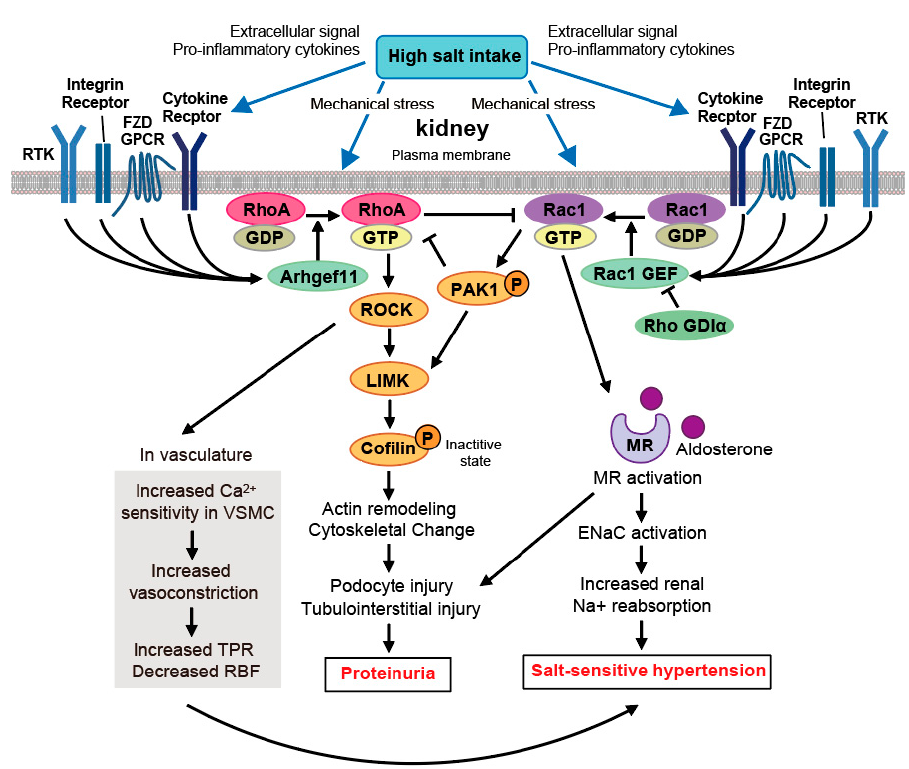
Figure 2. Cross talk between RhoA and Rac1 in salt-sensitive hypertension and renal injury in the kidney of Dahl salt-sensitive (DS) rats. In DS rats, a high-salt diet causes salt-sensitive hypertension and exacerbates renal damage, which is closely related to the activation of RhoA and Rac1 in the kidney. Various extracellular stimuli activate Rho GTPases via their receptors such as G-protein coupled receptors (GPCRs) [115], receptors of the tyrosine kinase (RTKs) [116], cytokine receptors [117], and integrin receptors [118] as well as Wnt and Notch signaling [119,120] by activating specific guanine nucleotide exchange factors (GEFs) [121]. Mechanical stress also stimulates RhoA and Rac1 [122]. It is known that salt intake increases the production of cytokines such as IL-1 β and IL-17 in the blood, resulting in salt-sensitive hypertension [123] and that cytokines activate Rac1 [117]. In addition, Wnt5a is produced by macrophages and adipocytes via paracrine and autocrine upon external stimuli and further promotes cytokine production and secretion [124]. While Wnt5a is involved in enhancing inflammation, it activates RhoA [13,125]. These findings suggest that salt intake stimulates cytokine and Wnt protein production from macrophages and tissues and activates Rac1 and Rho, although the detailed mechanism of Rac1 and RhoA activation by high-salt diet is still unknown. In the kidneys of high-salt-fed DS rats, RhoA is activated by Arhgef11, which is activated by salt intake, and ROCK and LIM-kinase (LIMK) are sequentially activated, and cofilin activity is suppressed, resulting in actin polymerization and remodeling in glomerulus tubules and interstitium leading to marked proteinuria and tubulointerstitial injury. In the vasculature, activated ROCK increases vasoconstriction through increased Ca 2+ sensitivity in VSMCs, increases total peripheral resistance (TPR), and decreases renal blood flow (RBF), thereby contrib- uting to the development of salt-sensitive hypertension. On the other hand, salt intake activates Rac1 by Rac1-GEF, which synergistically activates mineralocorticoid receptors (MR) with aldoste- rone and increases sodium reabsorption via epithelial sodium channel (ENaC) in the renal collect- ing duct, resulting in salt-sensitive hypertension with glomerular and tubulointerstitial injury. Rac1 activates downstream p21-activated kinase 1 (PAK1), but PAK inhibits RhoA, and RhoA inhibits Rac1. Since PAK activates LIMK, there is LIMK-mediated crosstalk between RhoA and Rac1 in the DS kidney, and both are involved in the development of salt-induced renal injury. 7. Aging Vasculature 7.1. Aging-Associated Hypertension via Noncanonical Wnt-RhoA/PCP Signaling Wnt signaling is one of the fundamental mechanisms associated with many biologi- cal processes, including cell differentiation, proliferation, polarity, and migration; it regu- lates embryonic and adult stem-cell development and adult tissue homeostasis [126]. The